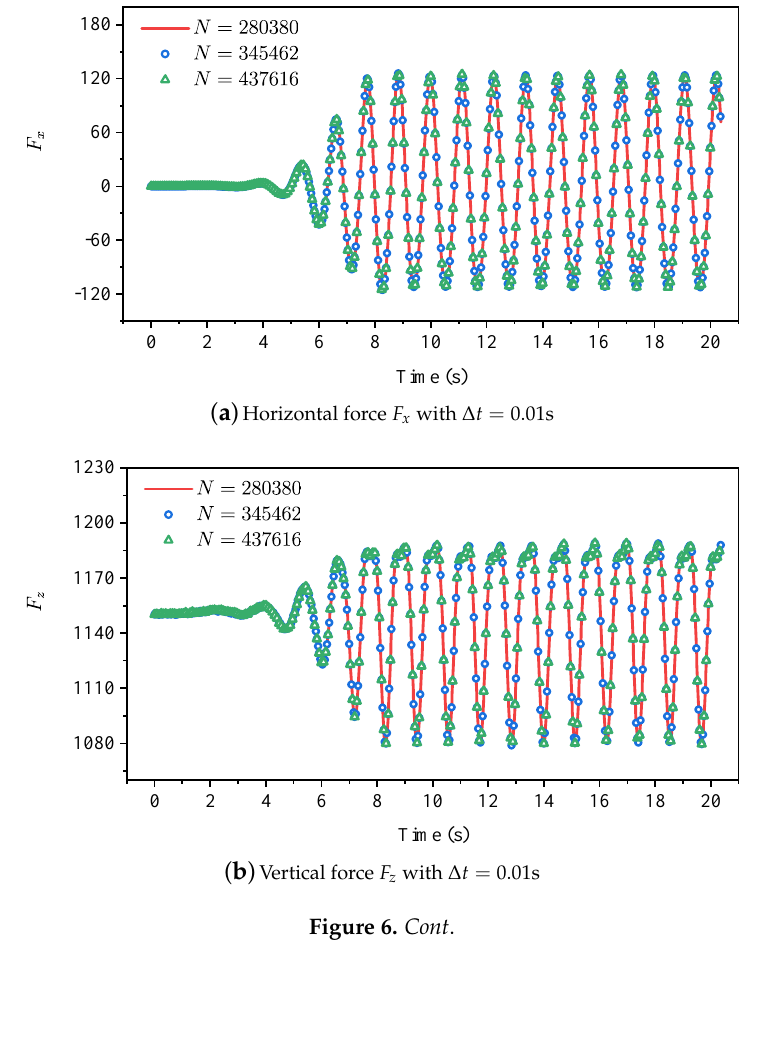
( b ) Vertical force F z with ∆ t = 0.01s Figure 6. Cont